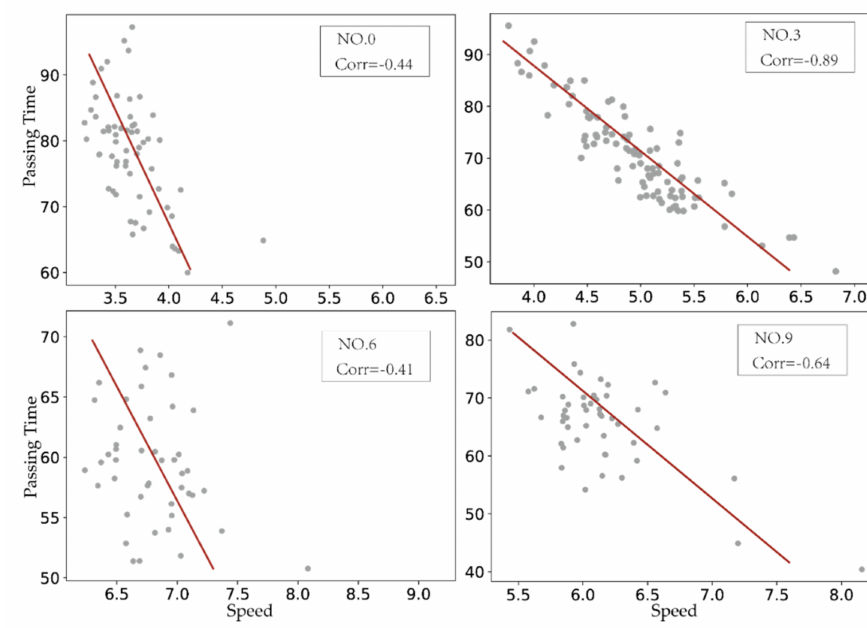
Figure 12. The correlation degree of intersection.